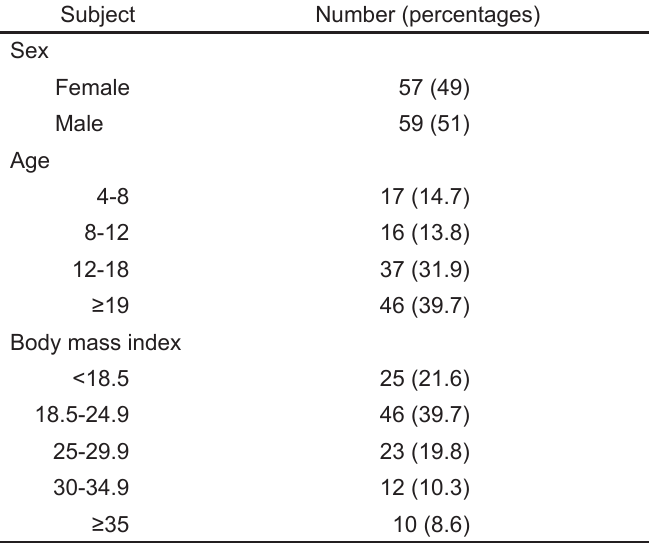
Table 1. Subject demographic characteristics.